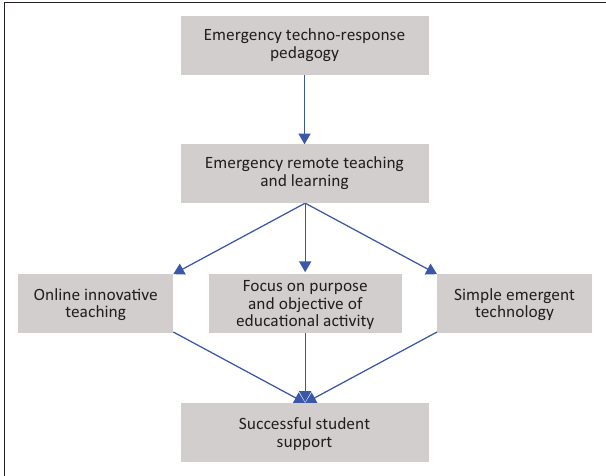
FIGURE 1: Emergency techno-response